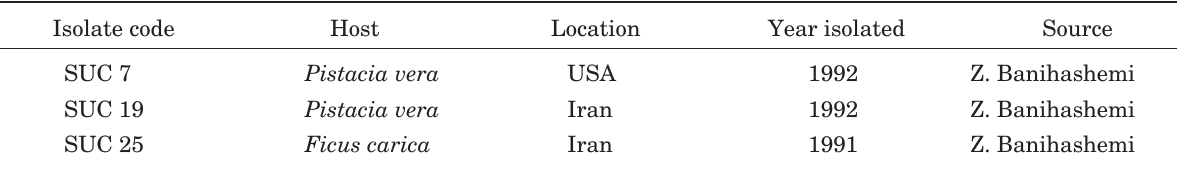
Table 1. Sources of isolates of Phytophthora parsiana